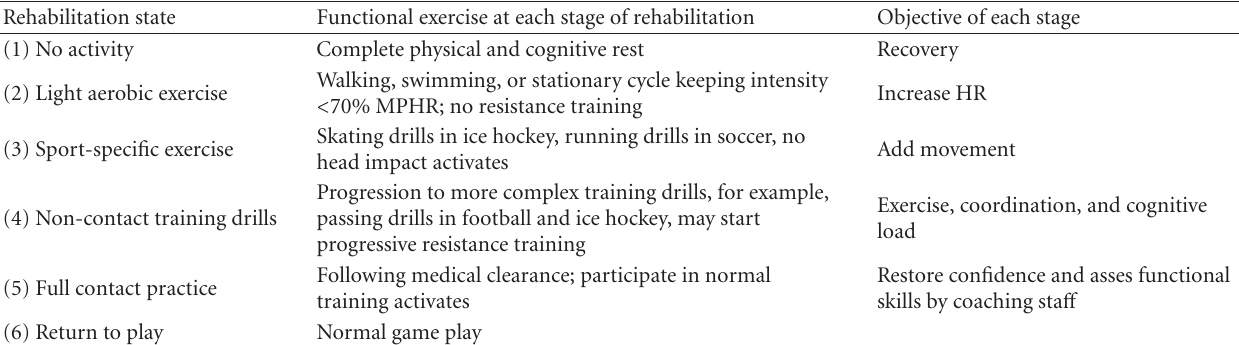
Table 1: Graduated return to play protocol established at the 3rd international conference on concussion in sport.